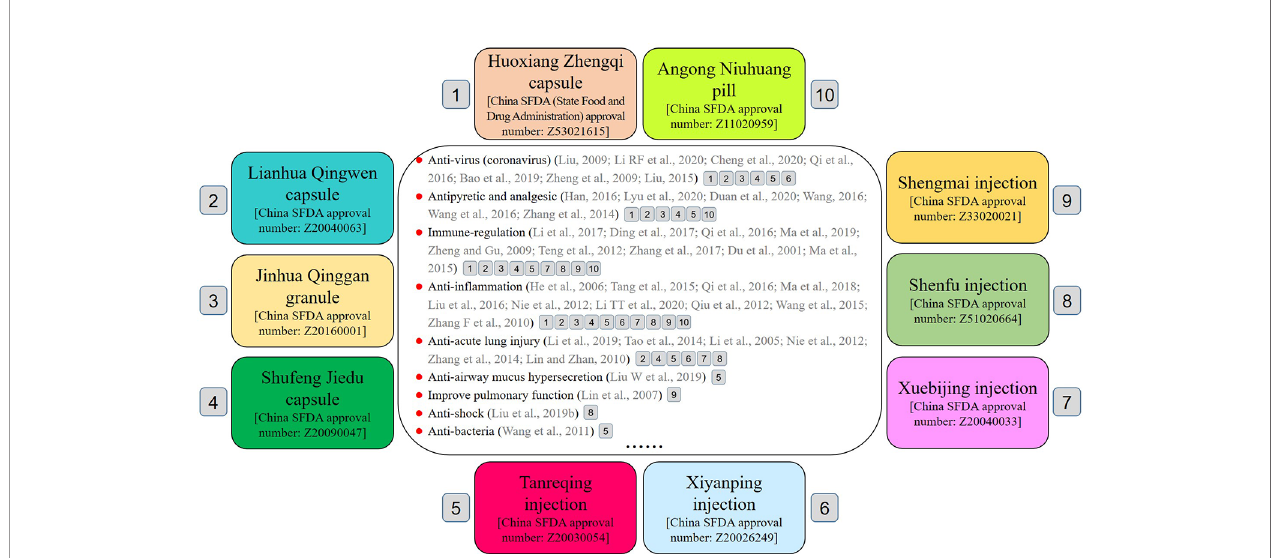
FIGURE 1 | The top 10 CPMs for the treatment of COVID-19: 1) Huoxiang Zhengqi capsule (HXZQC), 2) Lianhua Qingwen capsule (LHQWC), 3) Jinhua Qinggan granule (JHQGG), 4) Shufeng Jiedu capsule (SFJDC), 5) Tanreqing injection (TRQI), 6) Xiyanping injection (XYPI), 7) Xuebijing injection (XBJI), 8) Shenfu injection (SFI), 9) Shengmai injection (SMI), and 10) Angong Niuhuang pill (AGNHP).